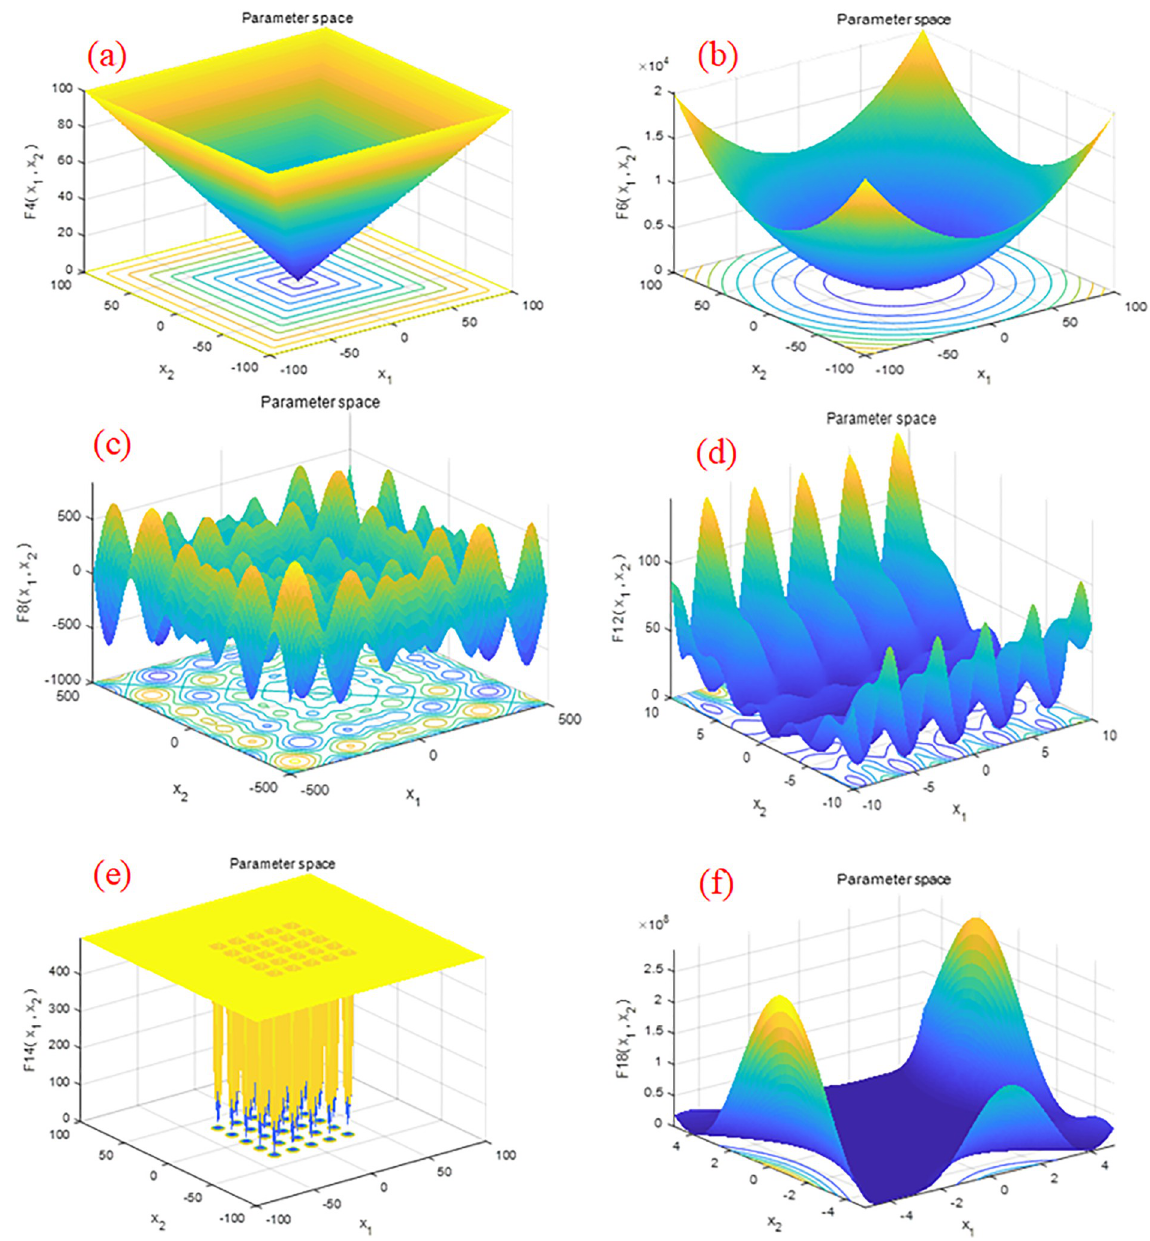
Fig 4. Typical 2D representations of benchmark mathematical functions: (a), (b) unimodal functions, (c), (d) multimodal functions, and (e), (f) fixed-dimension multimodal functions.